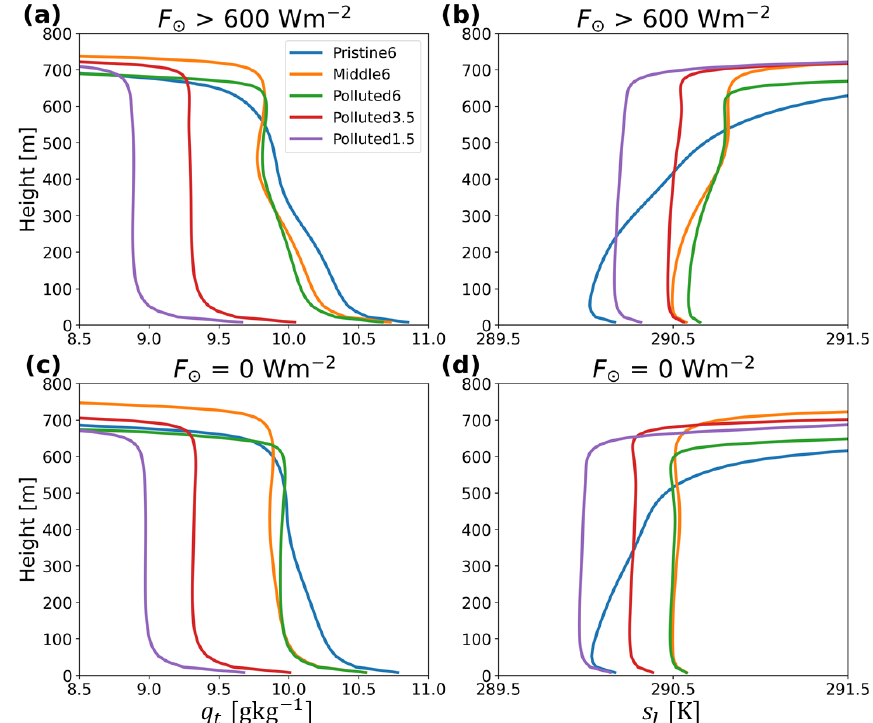
Figure 3. Vertical profiles of (a, c) q t and (b, d) s l averaged during (a, b) day and (c, d) nighttime for the Ctrl case.